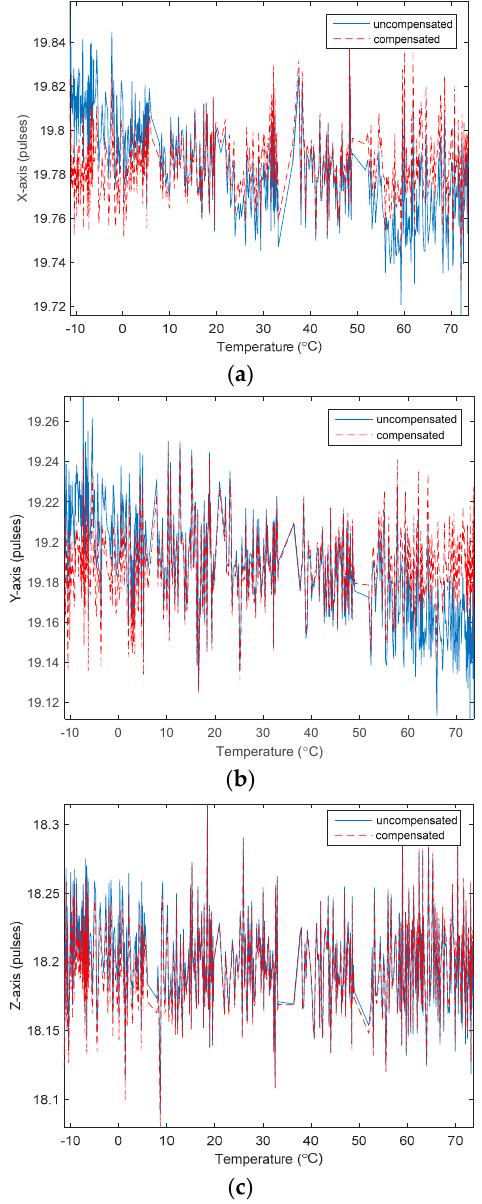
Figure 5. Bias of RLGs before and after the static temperature model compensation. ( a ) X -axis of gyro; ( b ) Y -axis of gyro; ( c ) Z -axis of gyro.